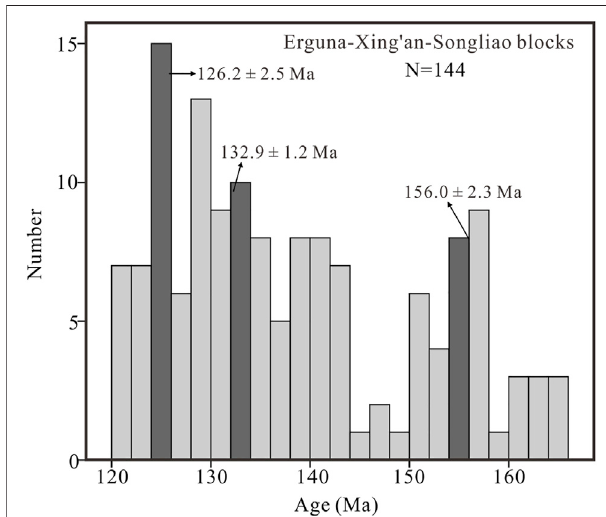
FIGURE 6 | Histogram of the U – Pb ages of zircons from Mesozoic igneous rocks in the Erguna-Xing ’ an-Songliao Blocks. Age data sources: Wang et al., 2006; Zhang et al., 2010; Wu et al., 2011; Tang et al., 2015; Li et al., 2018; Ji et al., 2020, 2021 and this study.